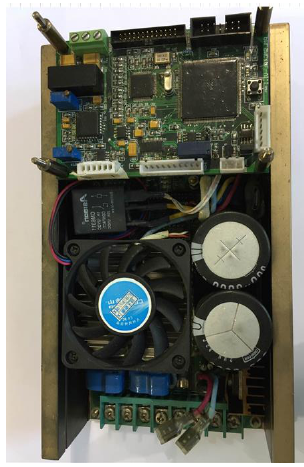
Figure 12. Photo of the controller.